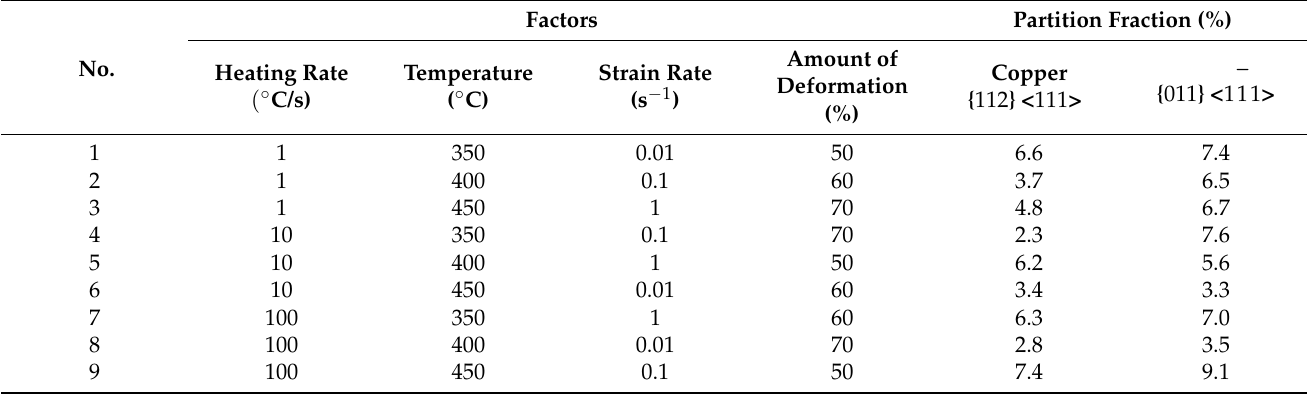
Table 5. The partition fraction of Copper {112} <111> and {011}